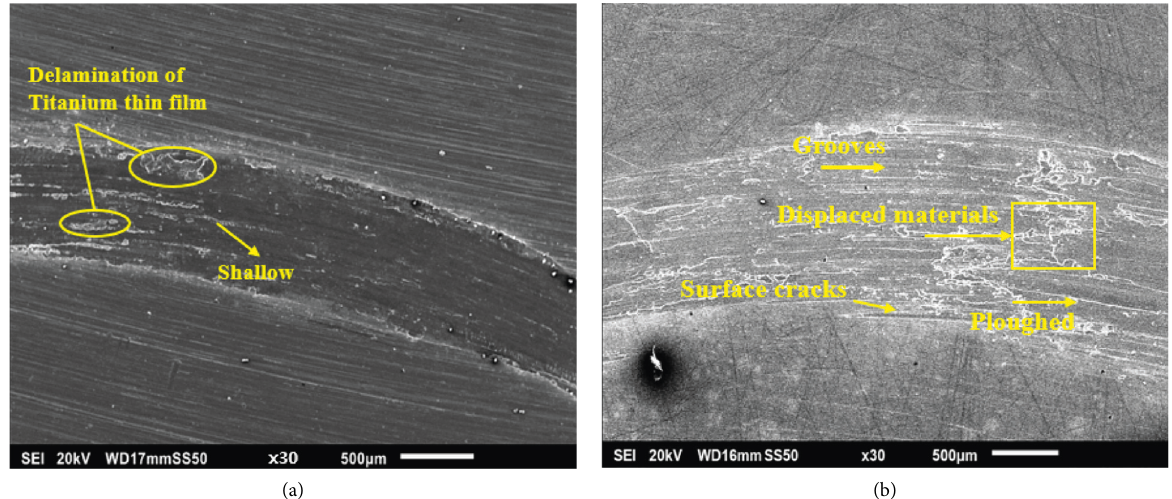
Figure 6: SEM image of the wear track surface morphology ( × 30): (a) A4; (b)